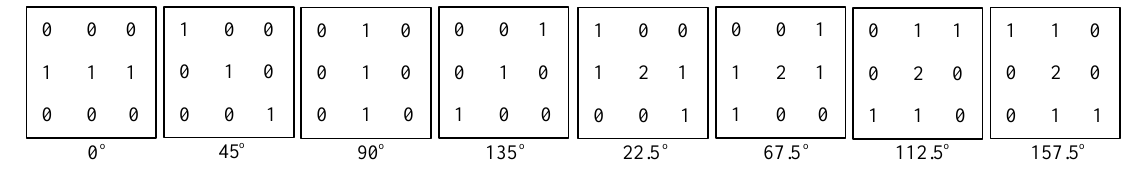
Figure 3. The direction of the template.